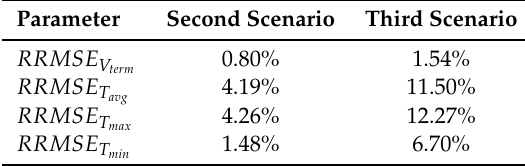
Table 12. RRMSEs for the module-to-module discretization battery pack model